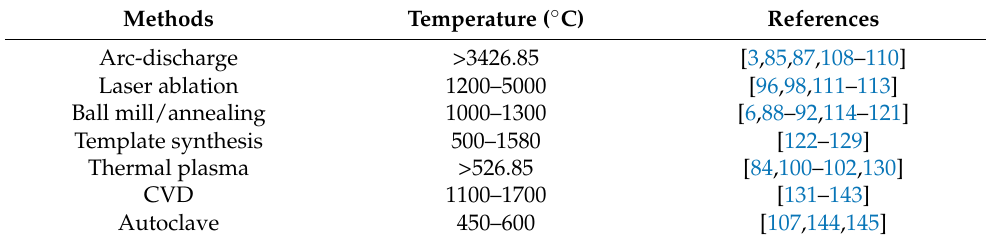
Table 3. Summary of different synthesis methods for